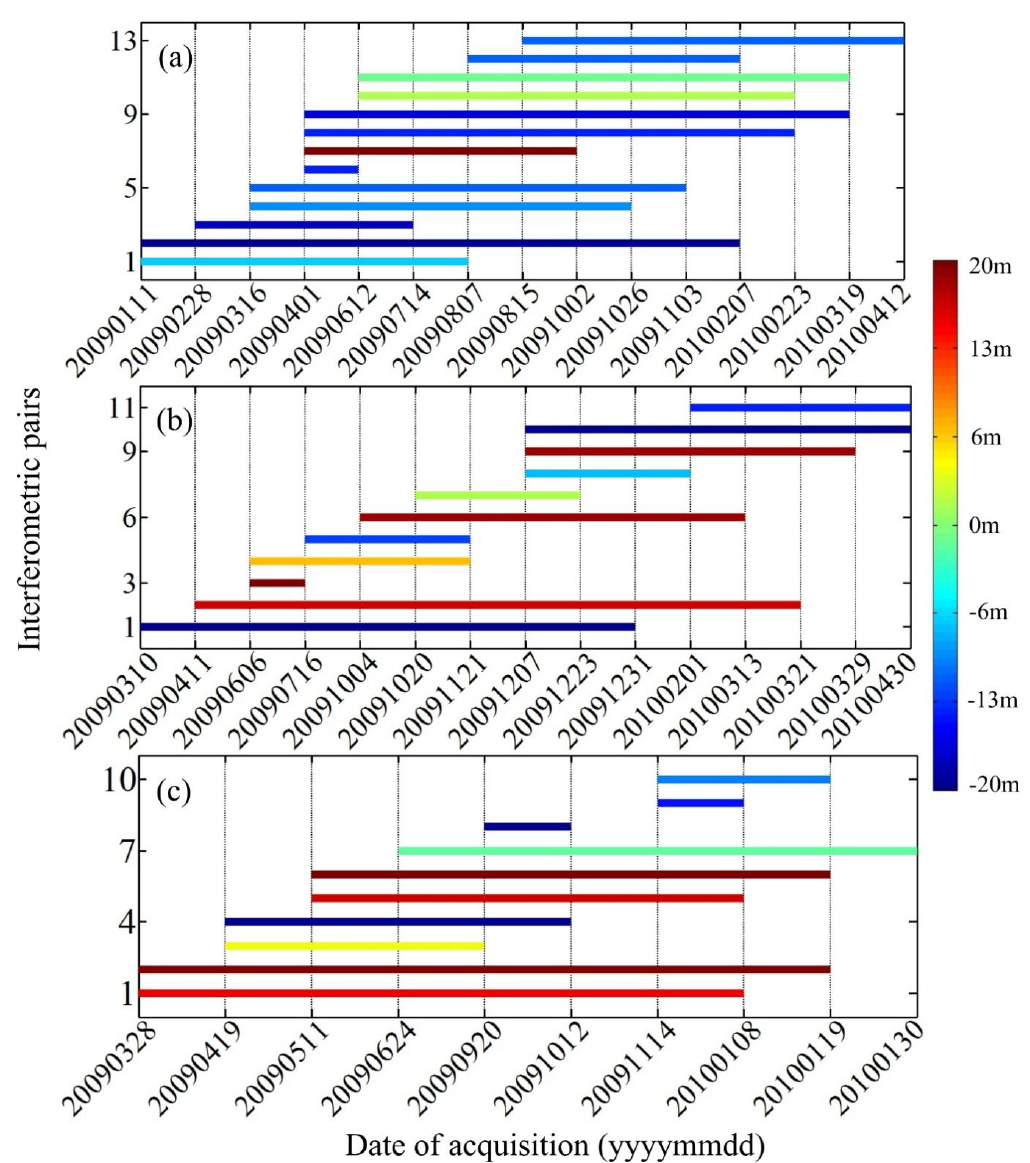
Figure 3. The spatial and temporal baselines of the interferometric pairs selected for the cases of ( a ) ascending CSK; ( b ) descending CSK; and ( c ) descending TSX, respectively. The color bar indicates the spatial baseline length of each interferometric pair, and the horizontal line indicates the temporal baseline ( i.e. , time interval) for the corresponding interferometric